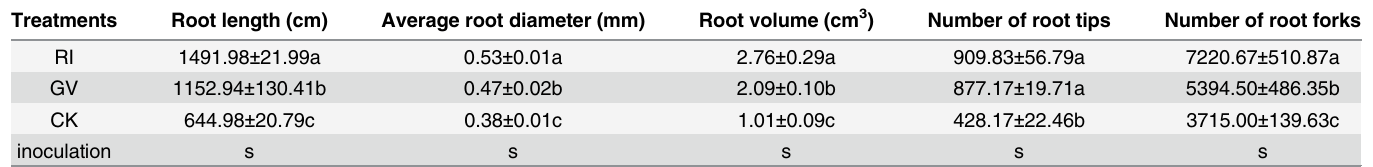
Table 2. Effect of AM fungi inoculation on root morphological characters. Treatments